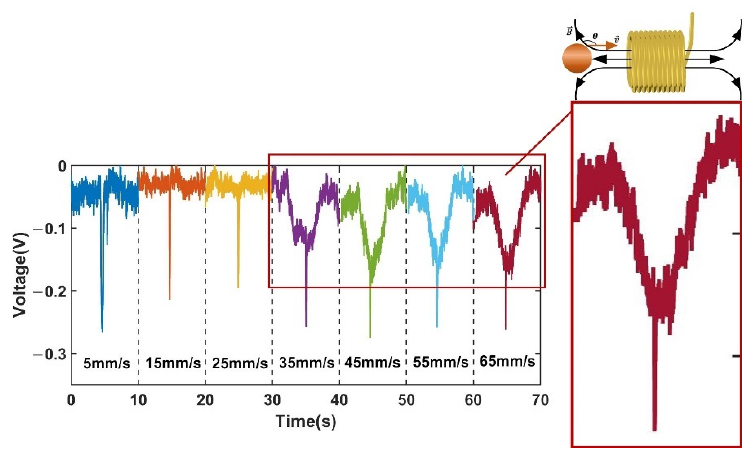
Figure 12. Comparison of signals at different velocities for 350 μ m aluminum.